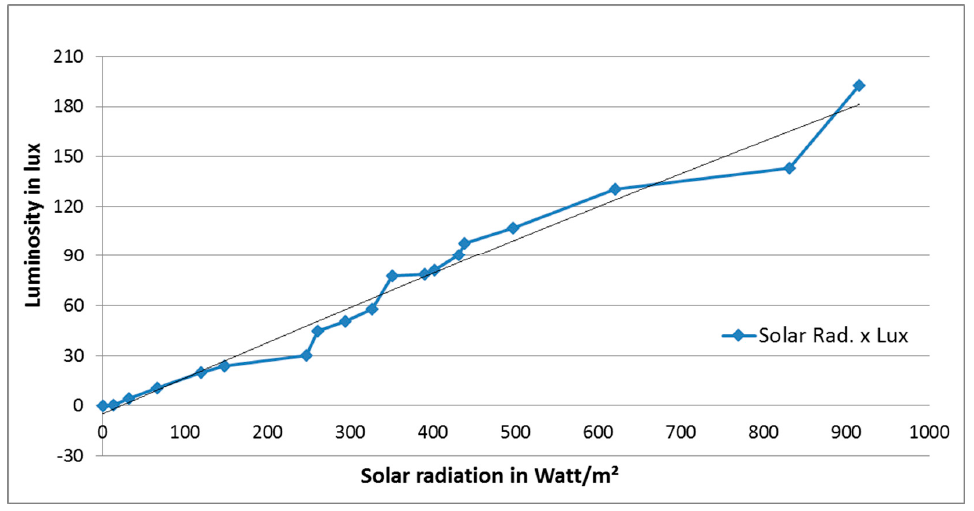
Figure 6. Relation between solar radiation and internal luminosity of the test room in which it has commercial pipe.